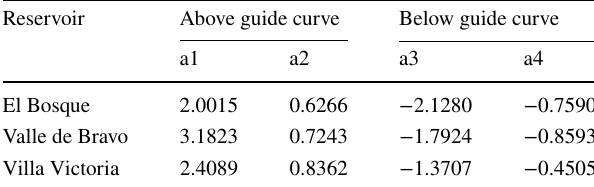
Table 6 Optimal parameters of Eqs. 3 and 4 for genetic algorithm GA2 policy Reservoir Above guide